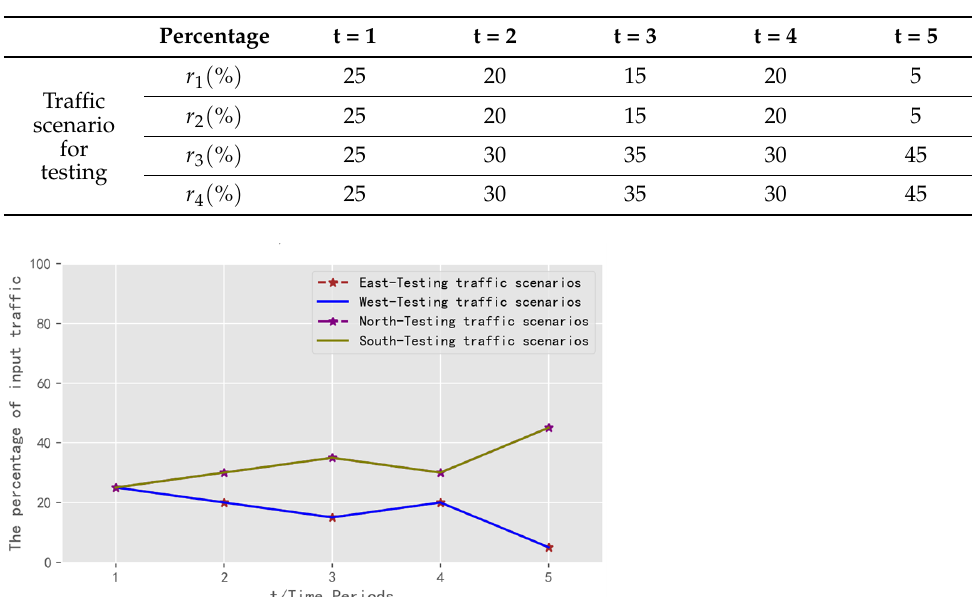
Table 13. Design of traffic scenario 1 for testing: allocation of vehicles in each direction.